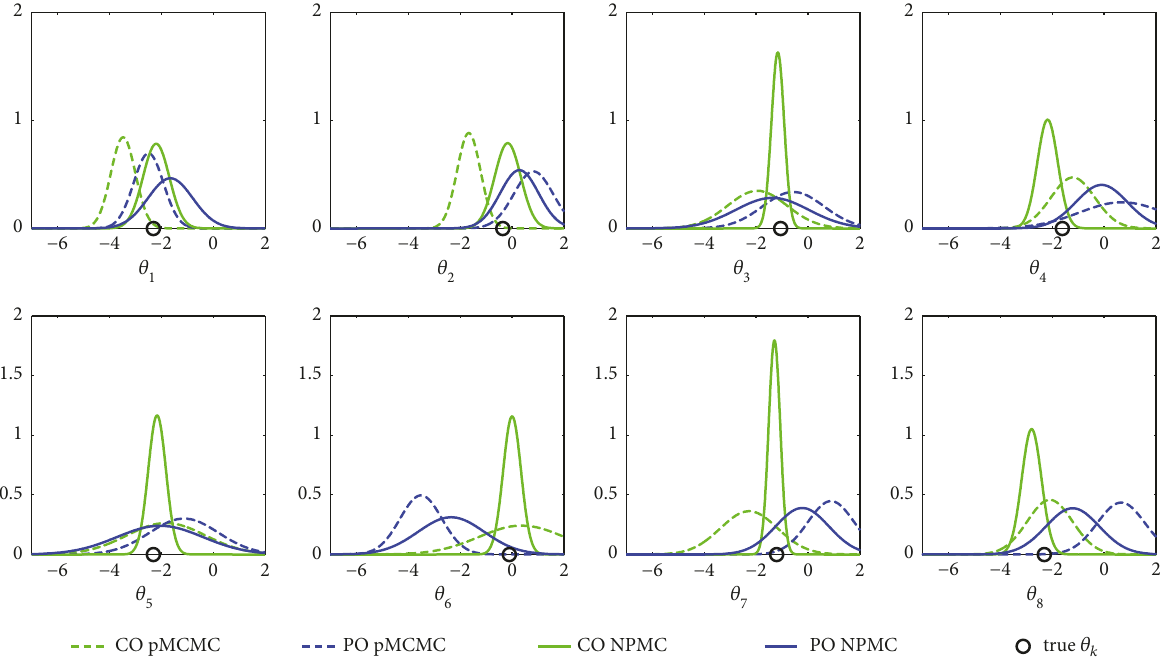
Figure 8: Marginal posterior pdf approximations of each parameter ̂𝑝(𝜃 𝑘 | y ) , 𝑘 = 1,. .. ,𝐾 , attained in an average simulation run by the pMCMC and the NPMC, in the CO and in the PO